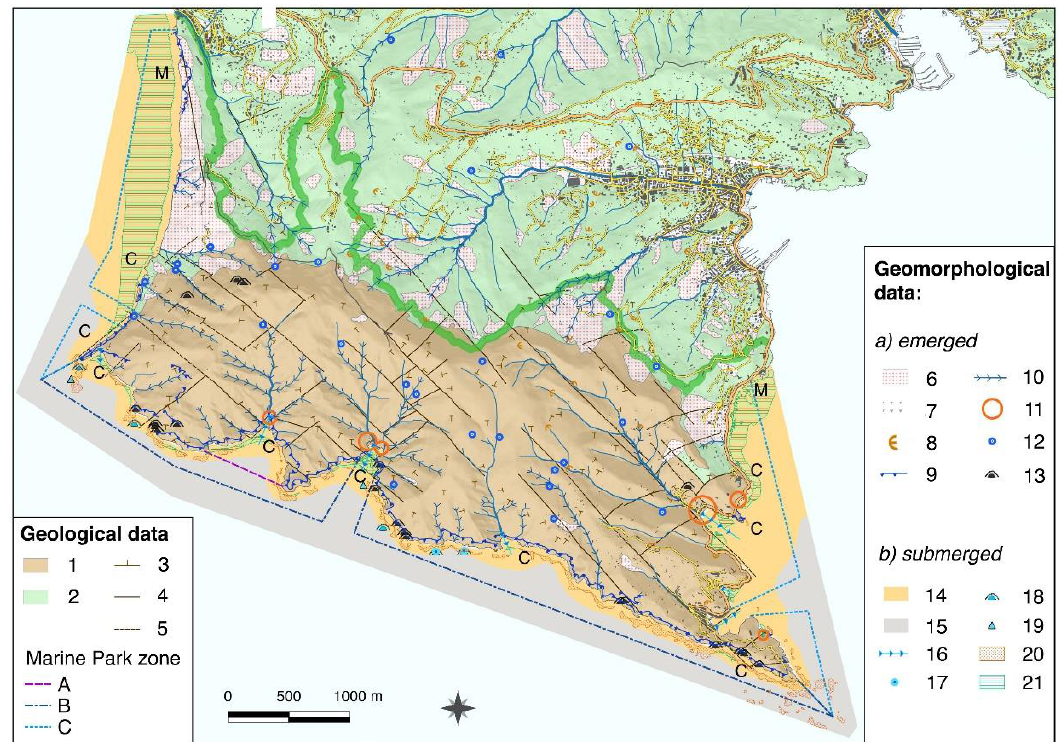
Figure 2. Geological and geomorphological sketch of the study area (modified from [11,86–88]): ( 1 ) Conglomerate; ( 2 ) marly limestone flysch; ( 3 ) bed attitude; ( 4 ) fault; ( 5 ) tectonic lineament; ( 6 ) landslide and debris covers; ( 7 ) anthropic fill; ( 8 ) soil slip; ( 9 ) edge of sea cliff scarp; ( 10 ) incising channel; ( 11 ) pocket beach; ( 12 ) spring; ( 13 ) cave; ( 14 ) submerged cliff with boulders, sands in the small bays (San Fruttuoso, Portofino and Paraggi); ( 15 ) sea bottom with sands and muddy sands; ( 16 ) submerged channel; ( 17 ) submerged spring; ( 18 ) submerged cave; ( 19 ) submerged peak; ( 20 ) coralligenous reef; ( 21 ) seagrass meadow.